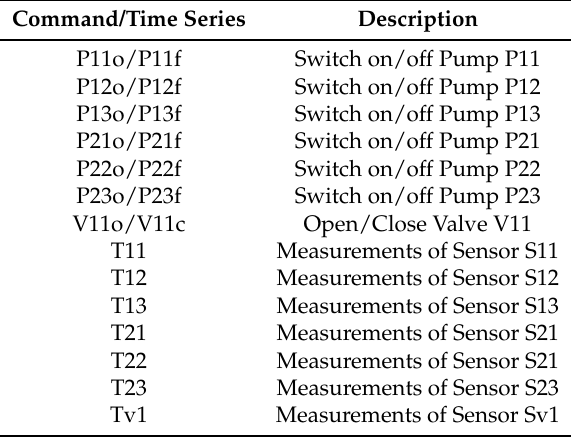
Table 1. Description of data in the tank